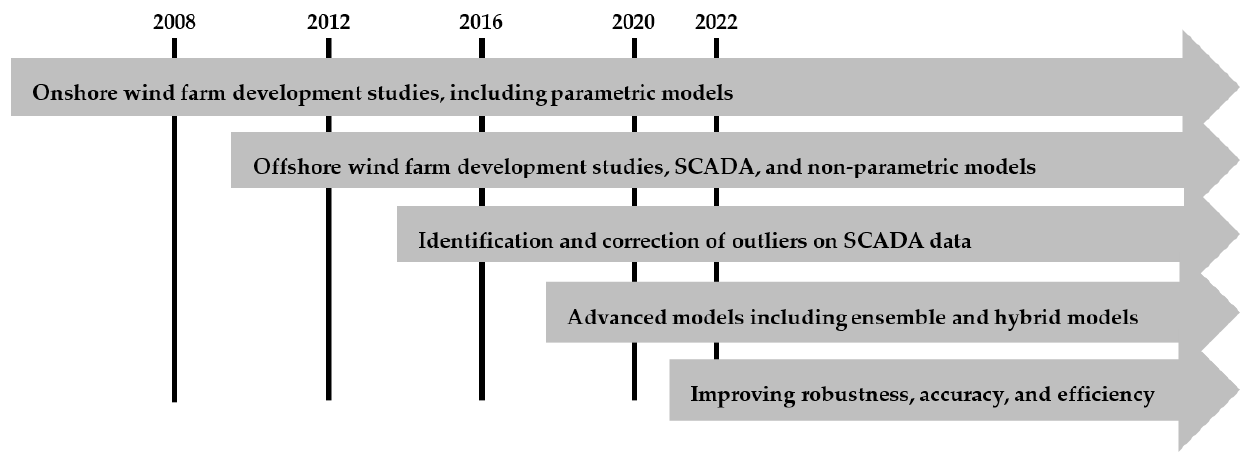
Figure 15. Evolution and important milestones. Table 9. Main trends over the years.